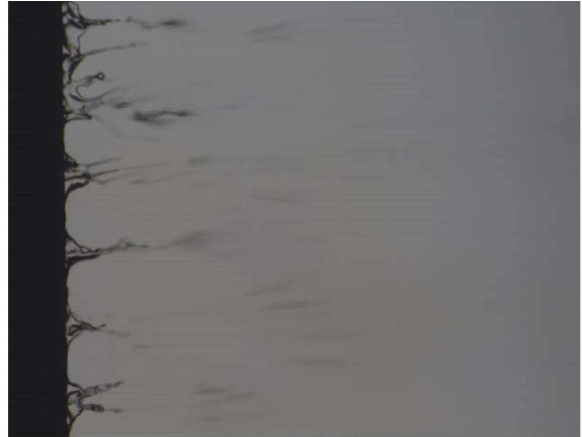
Fig. 4. An example of liquid break-up on the trailing edge of the blade .